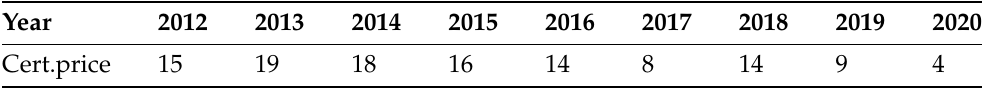
Table 16. The average market price of green certificates in the period of 2012–2020, cents of NOK per kWh produced